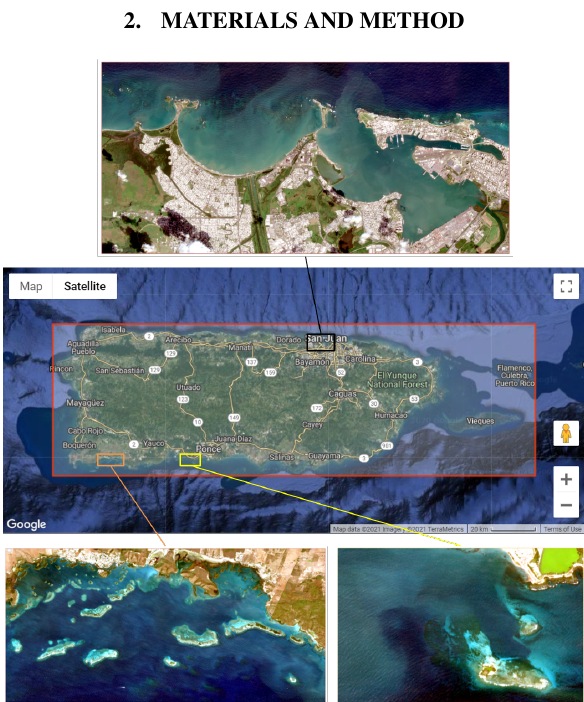
Figure 1. The area of study on several locations around Puerto Rico main island, with the visualization from Sentinel-2 images. Bottom-right, bottom-left, and top are Ponce, Southwest, and San Juan respectively.